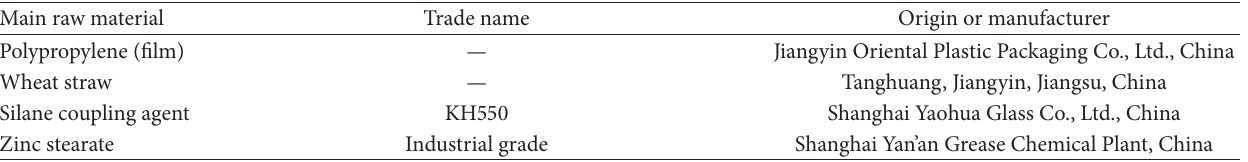
Table 1: Raw materials of the